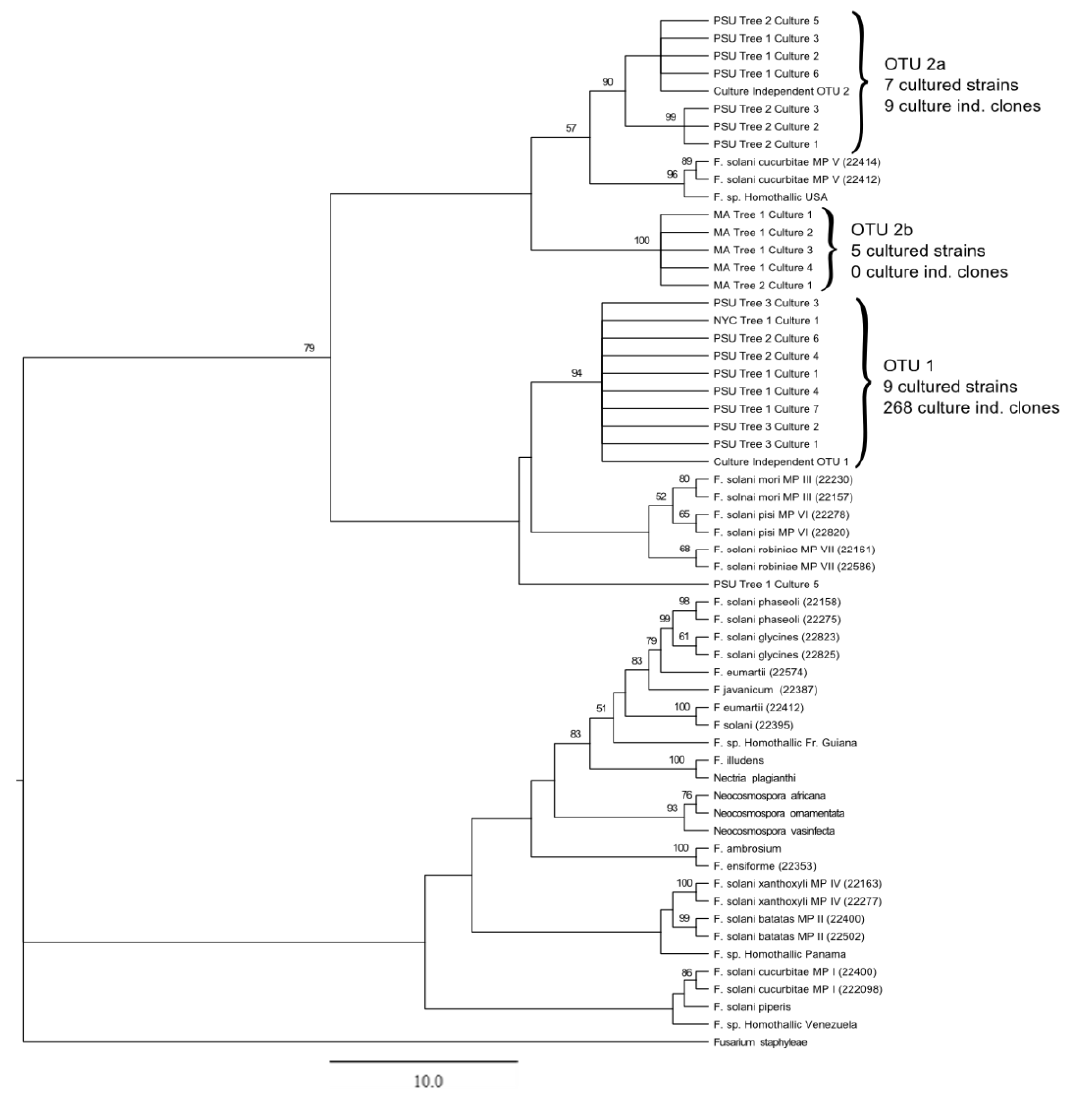
suggesting low genetic diversity among OTU1-derived F. solan i isolates. In addition, clade 2b (containing only MA-derived isolates) is still relatively invariant at the nucleotide level in comparison to clade 2a (containing PSU-derived isolates). Figure 1. Phylogenetic analysis of ALB-derived and O’Donnell Fusarium solani isolates using the translation elongation factor 1-alpha locus . A rooted maximum likelihood tree was generated using TEF1- α sequences from all cultured representatives and a single representative from each OTU detected through culture-independent methods (n = 500 bootstrap replicates). These sequences were placed within the F. solani species complex, utilizing the dataset of O’Donnell [44]. Mating populations (abbreviated MP) are listed based off of the O’Donnell dataset. Nodes with bootstrap support values > 50 are reported, ML distance scale bar = 10 changes. ALB-derived isolates formed 3 strongly supported clusters, denoted as OTU1, OTU2A, and OTU2B. A single NYC isolate and all culture- independent sequences generated from this population were grouped into OTU1, while all MA-derived isolates were classified into cluster 2b. PSU-derived isolates can be observed in both OTU1 and